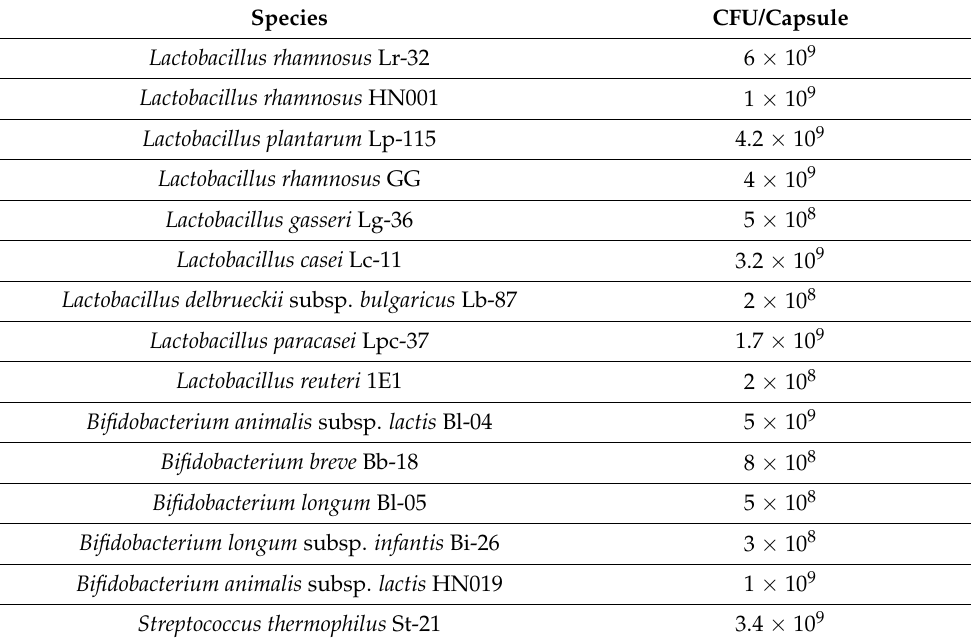
Table 3. Contents of broad-spectrum life-space probiotic (Melbourne, Australia).